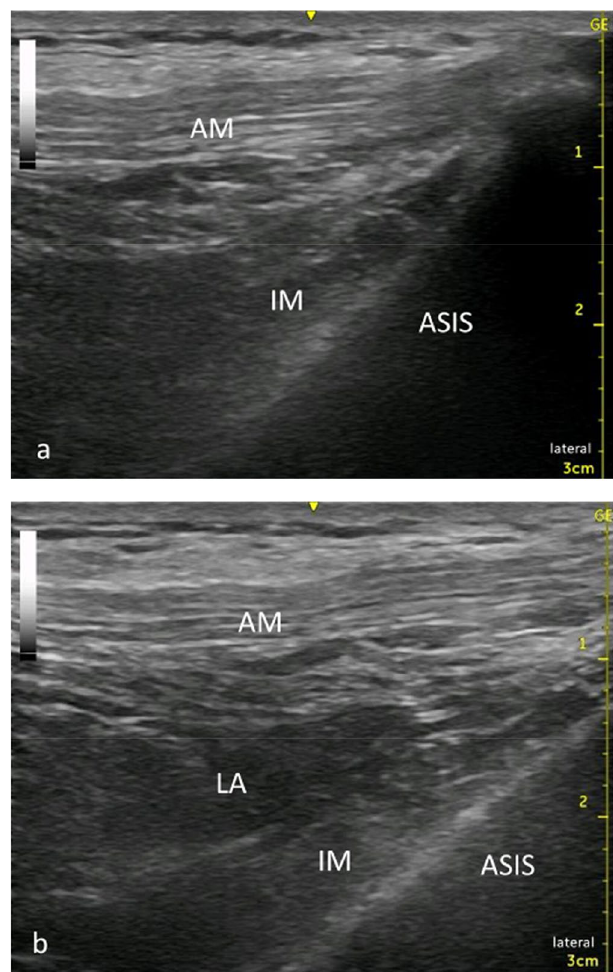
Figure 1. Ultrasound image of pre injection ( a ), ultrasound image of post injection ( b ). ASIS Anterior superior iliac spine, IM iliacus muscle, AM abdominal muscles, LA local anesthetic.